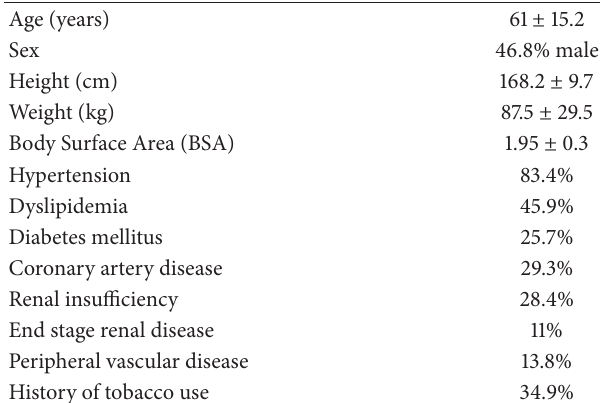
Table 1: Patient demographics, 𝑁 = 96